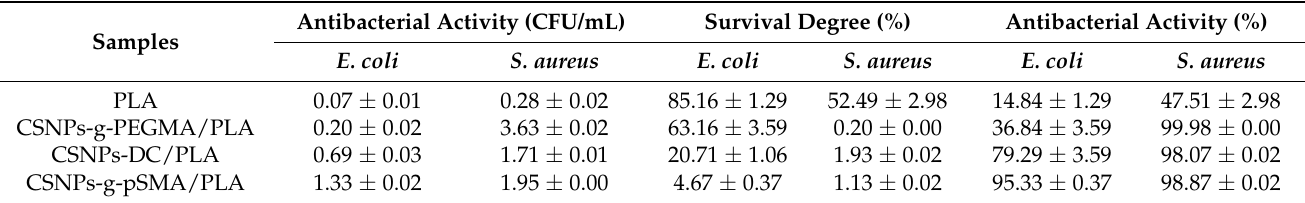
Table 13. Antibacterial activities of PLA films containing CSNPs derivatives. Ref. [108], published by Elsevier,